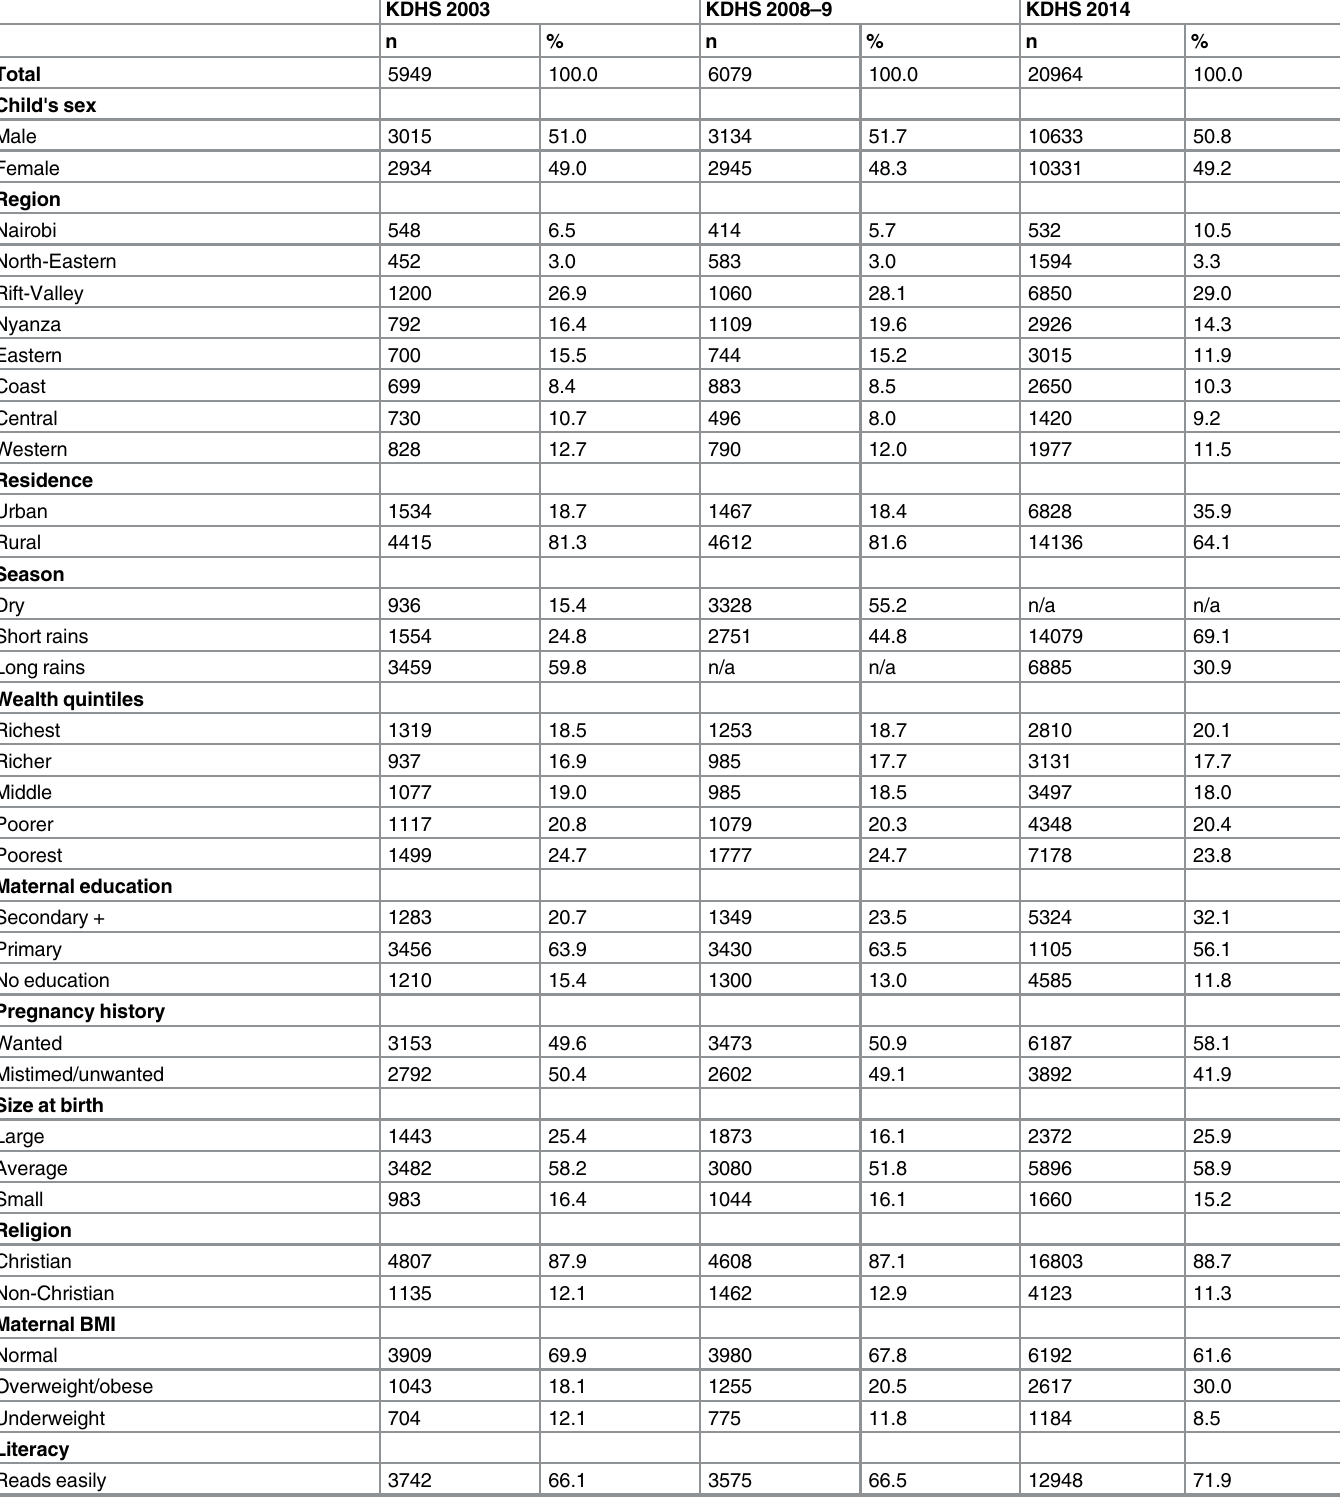
Table 1. Comparison of the socio-demographic characteristics of KDHS 2003, 2008 – 9 and the 2014